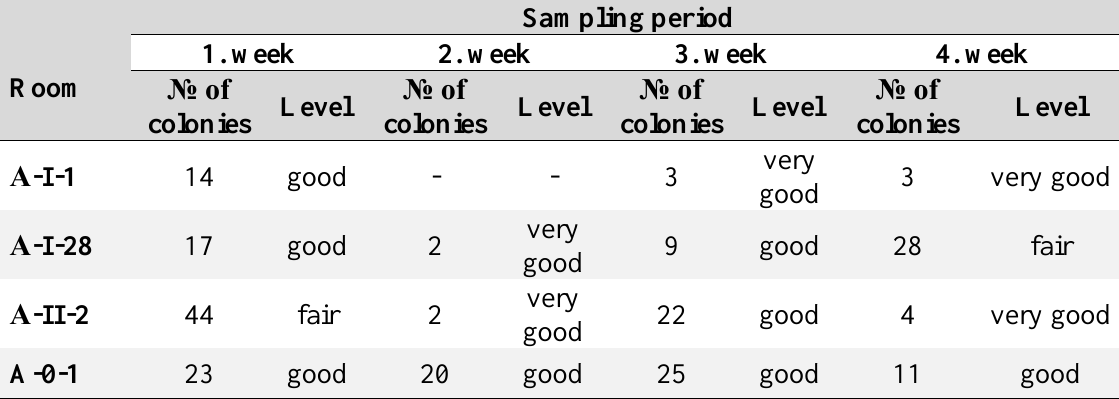
Table 2. The index of microbiological air contamination during the month of